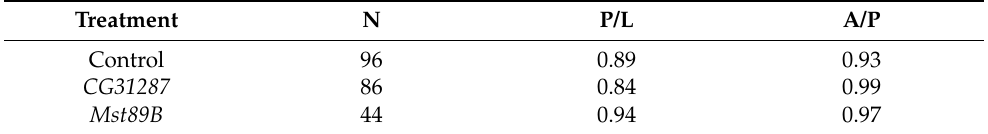
Table 1. Average proportion of larva to pupa (P/L) and pupa to adult (A/P) viability for wild-type